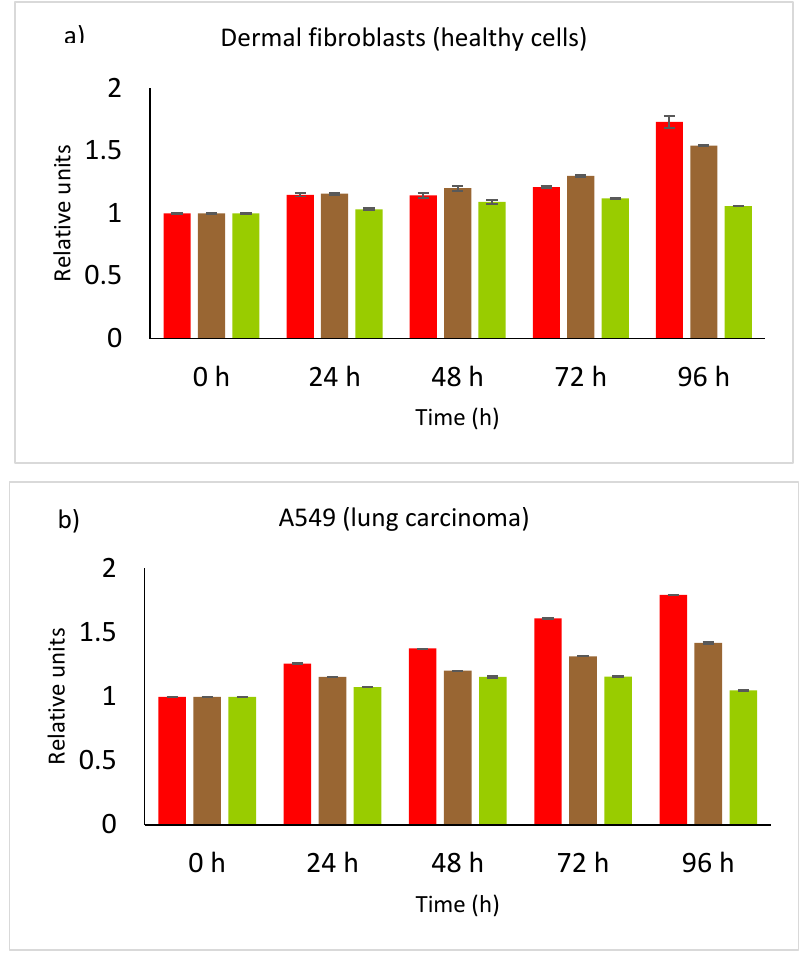
Figure 7. ( a ) Cell viability at different exposition times to TCDs for healthy dermal fibroblasts and ( b ) cell viability at different exposition times to TCDs for A549 lung carcinoma. Red color is control, brown is 100 ppm TCDs and green is 1000 ppm TCDs.